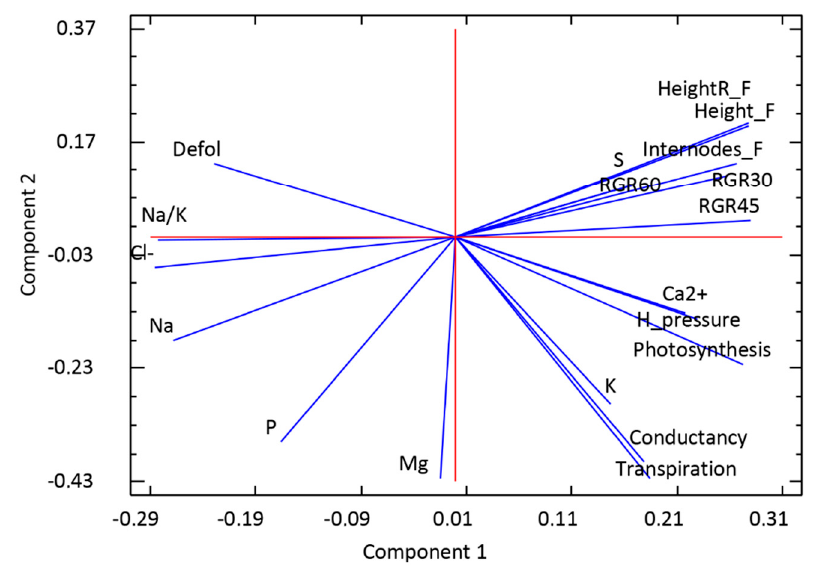
Figure 3. Principal component analysis of the physiological and morphological variables measured. A representation of the variables contributing to each component is included. Table 2. Physiological and nutritional phenotype of the plants between groups after 0, 30, 45, and 60